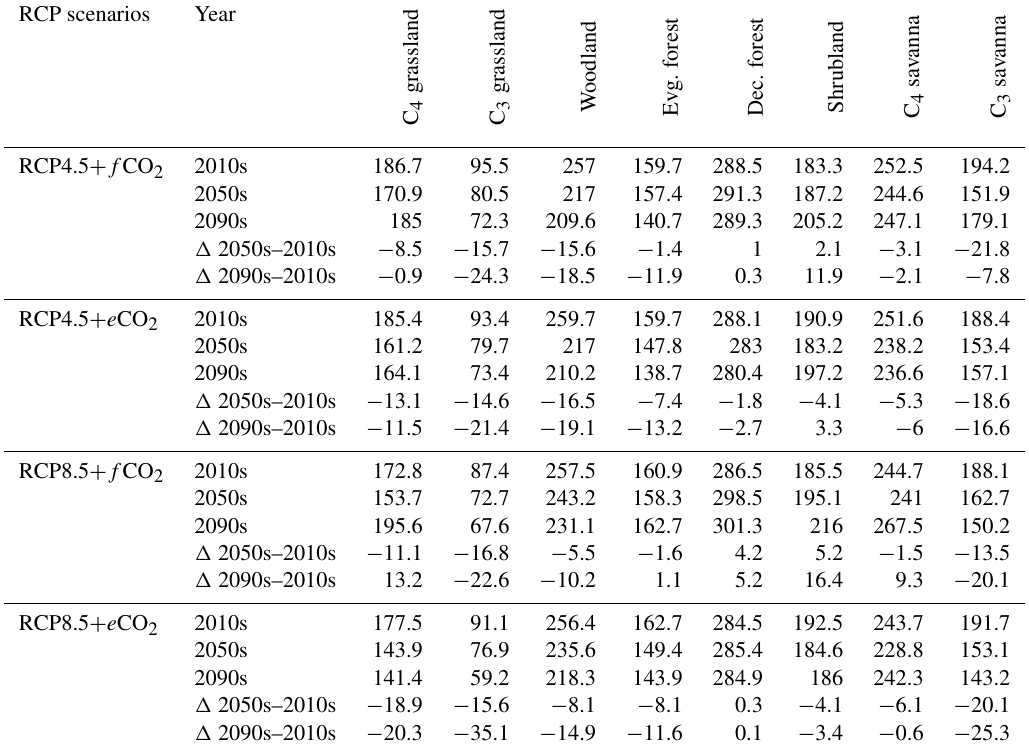
Table 3. Biome-level ET normalized to biomass ( E biome , mm/kg/year) for the 2000s, 2050s and 2090s, and percent (%) change in E biome from the 2000s to the 2050s and the 2000s to the 2090s under RCP4.5 and RCP8.5 with fixed and elevated CO 2 . (cid:49) indicates percentual ET changes between time